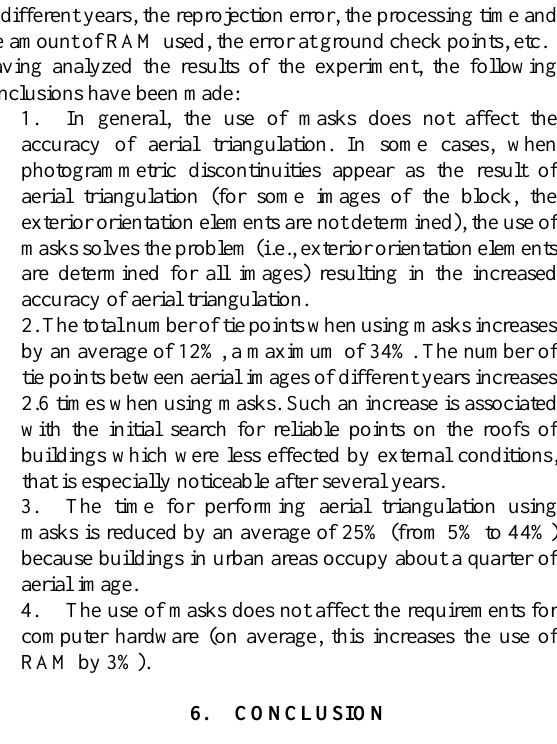
Table 4 . The accuracy verification for 50 ground check points.